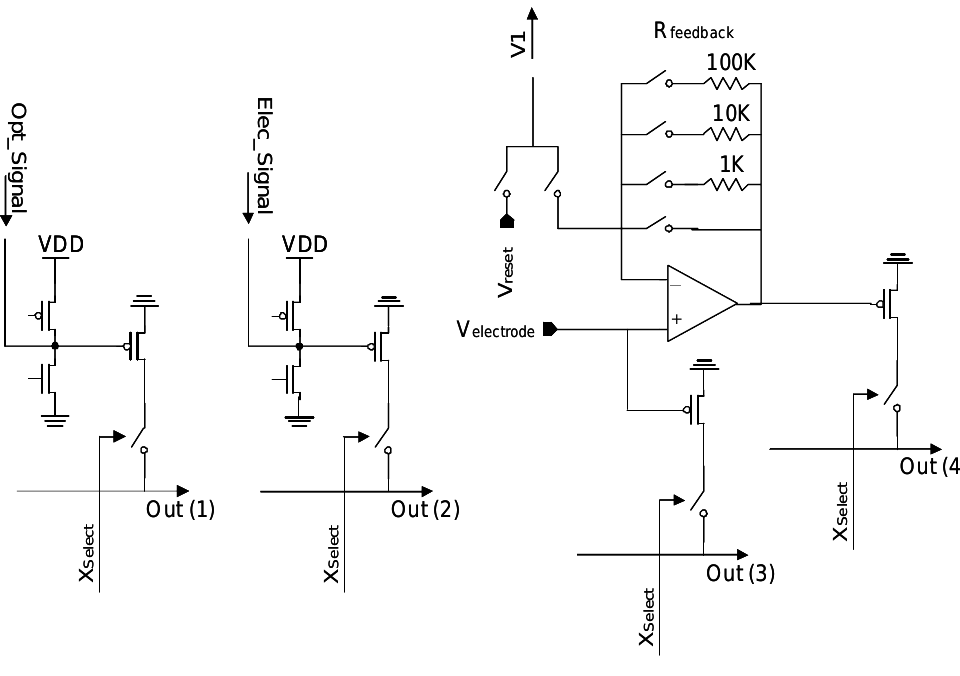
Figure 12. Schematic diagram of columnar circuitry (adapted from [5]